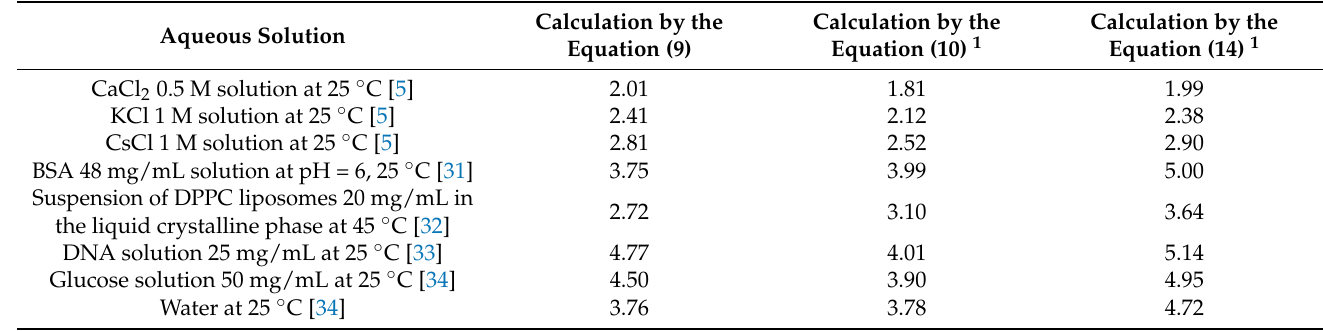
Table 1. Calculation of the proportion of free water molecules (in % of the total number) using three approaches: based on the ratio of the amplitudes of relaxation processes (9), based on the Langevin–Debye theory (10), based on the theory developed in this paper (14). Calculation by the Calculation by the Calculation by the Aqueous Solution Equation (9) Equation (10) 1 Equation (14)